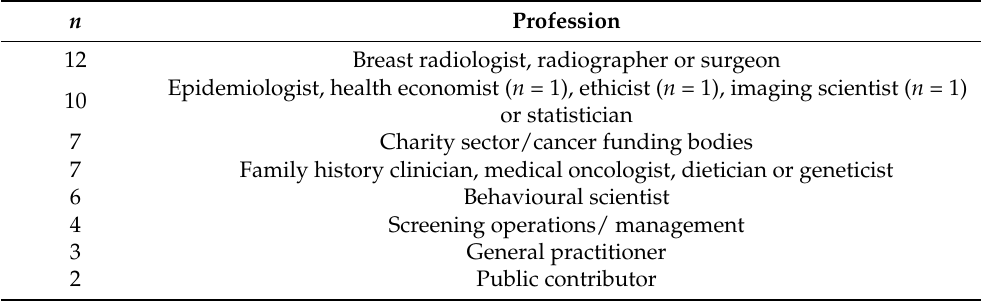
Table 2. Breakdown of primary profession of attendees (excluding